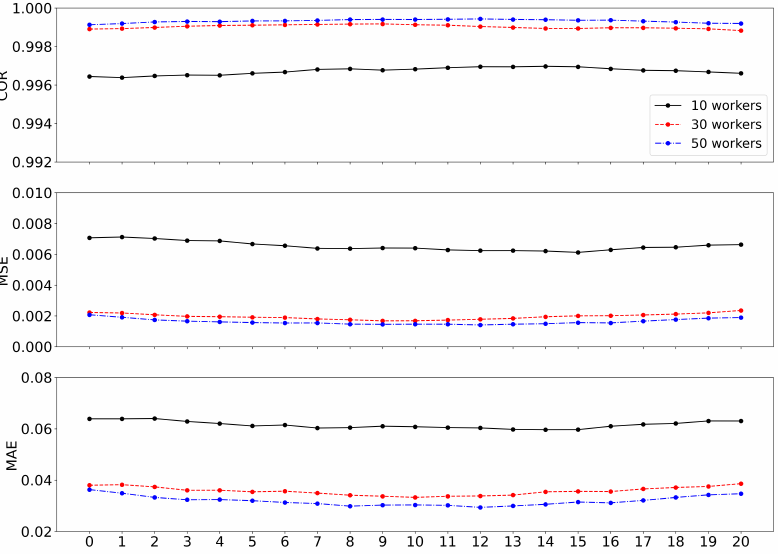
Figure 2. COR ( t ) , MSE ( t ) , and MAE ( t ) results for the datasets with the cases N w = 10,30,50 for each time t ∈ [ T ] 0